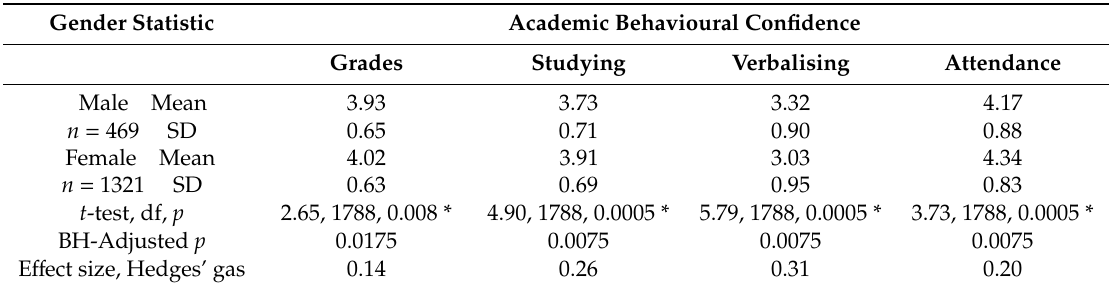
Table 4. Means and standard deviations for each of the academic confidence sub-scales by sex of